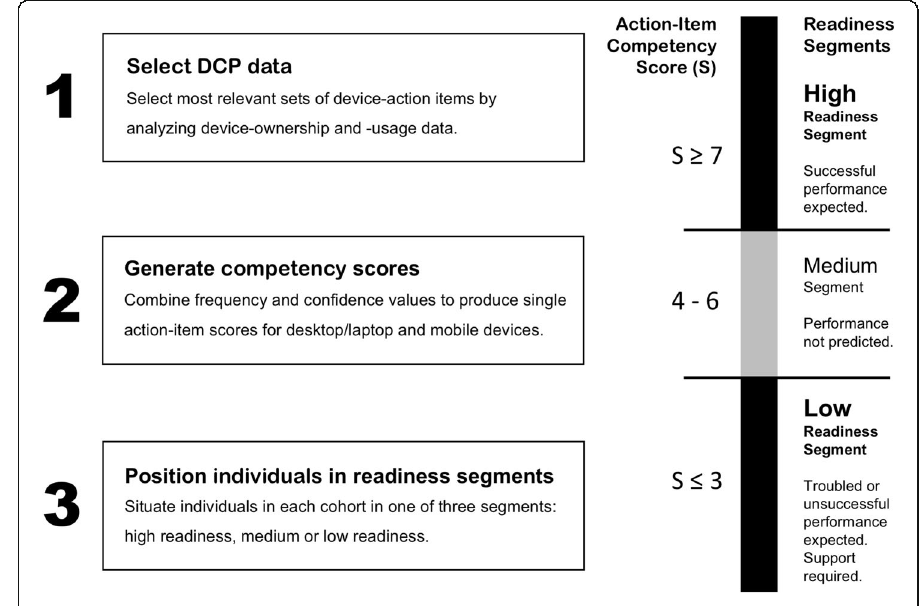
Fig. 3 DCP data-analysis